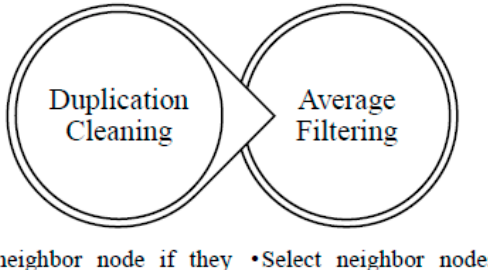
Figure 4. Two main steps in IACS method to remove the redundant neighboring node.